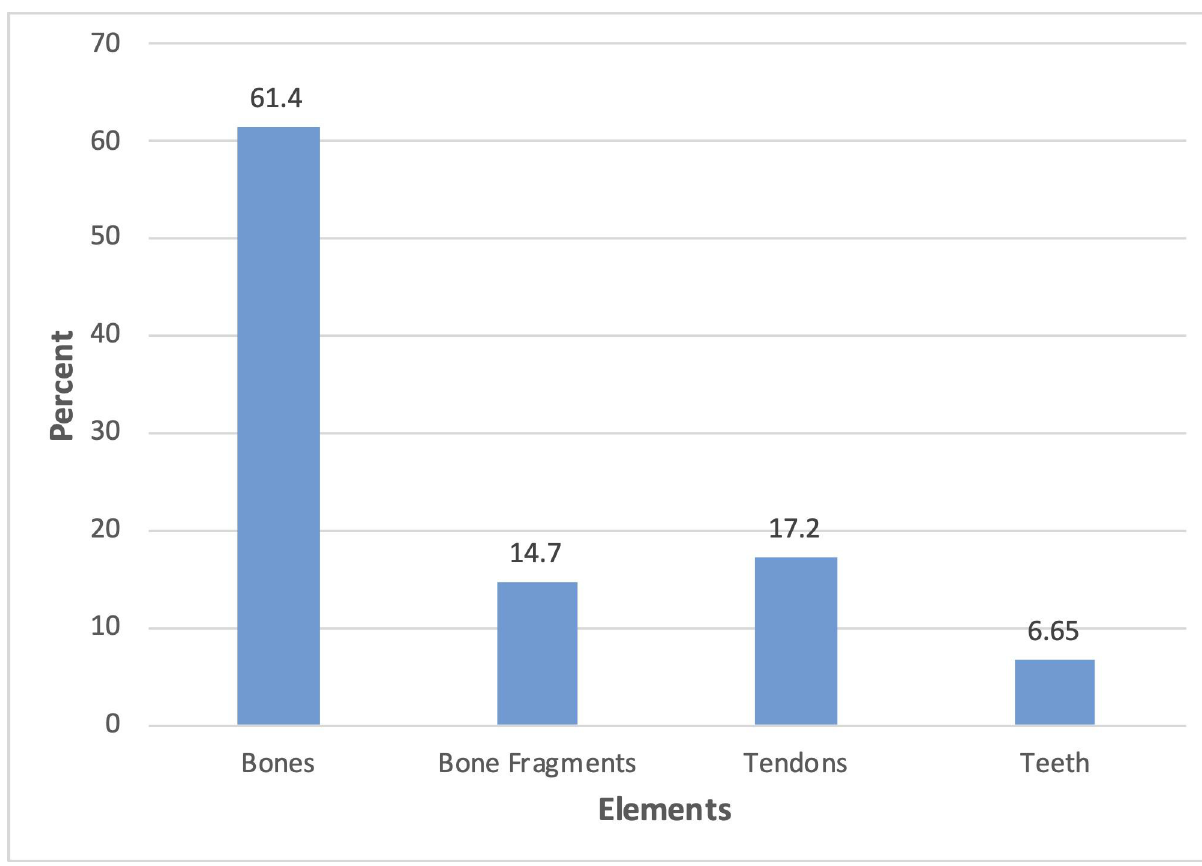
Fig 6. Skeletal element distribution for main quarries. Percentages out of 12,303 Edmontosaurus elements